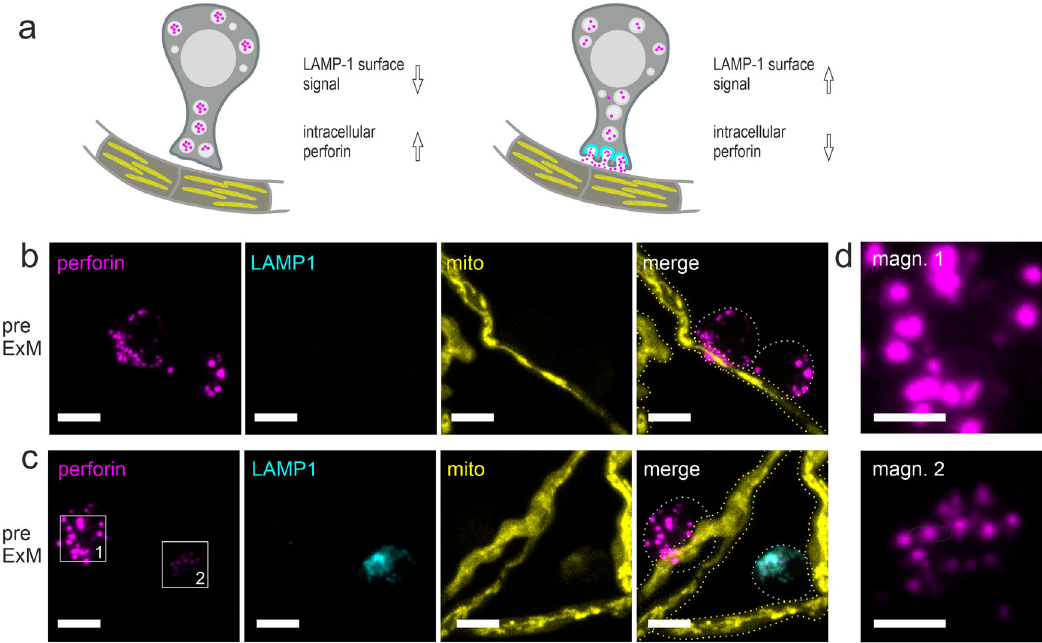
Fig. 4 NK-cell degranulation assay. a Schematic fi gure of NK-cell degranulation. Non-degranulated NK cells appear negative for degranulation marker LAMP1 (cyan), but positive for perforin (magenta). In contrast, after NK-cell degranulation in the presence of A. fumigatus hyphae and BFA, intracellular perforin is reduced and surface LAMP1 can be detected. b – d Visualization of surface LAMP1 (cyan) and intracellular perforin (magenta) in presence of the A. fumigatus (RFP-expressing mitochondria, yellow) with standard CLSM before ( b ) and after ( c ) degranulation. In c a degranulated NK cell (box 2) that appears positive for both, LAMP1 marker protein and perforin is shown together with a cell before degranulation (box 1). d Magni fi cation of the perforin signal shown in c . Note the difference in sizes and signal intensities for perforin post degranulation. NK cells and A. fumigatus hyphae were cocultured for 5 h. All images shown represent maximum intensity z-projections. Dotted lines indicate borders of NK cells (gray) and fungal hyphae (yellow). Representative images of two biological replicates. Scale bars, 5 µ m ( b , c ) and 2 µ m ( d